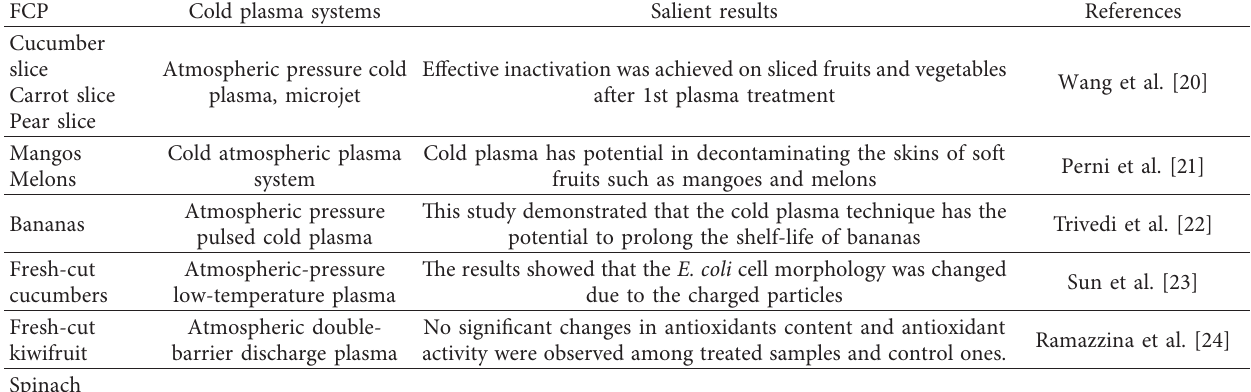
Table 1: Various cold plasma systems used for decontamination of different FCP.